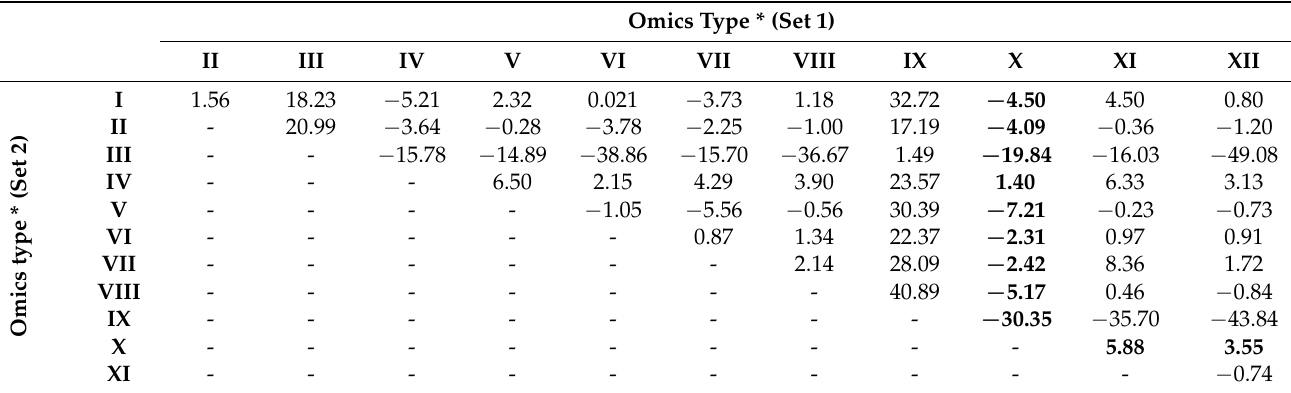
*Note 1: t-test statistics of the best omics combination are indicated in bold. Note 2: I (mRNA), II (methylation), III (miRNA), IV (mRNA, methylation), V (mRNA, miRNA), VI (mRNA, methylation, miRNA), VII (mRNA, clinical), VIII (methylation, clinical), IX (miRNA, clinical), X (mRNA, methylation, clinical), XI (mRNA, miRNA, clinical), XII (mRNA, methylation, miRNA,